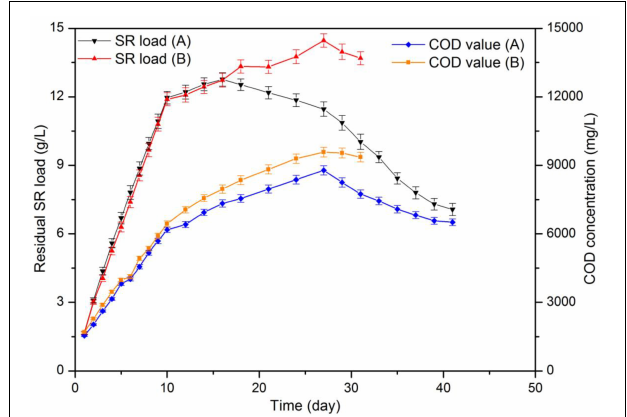
FIGURE 4 | Biogas yield and methane content in CSTR digestion of pork products after HTP.